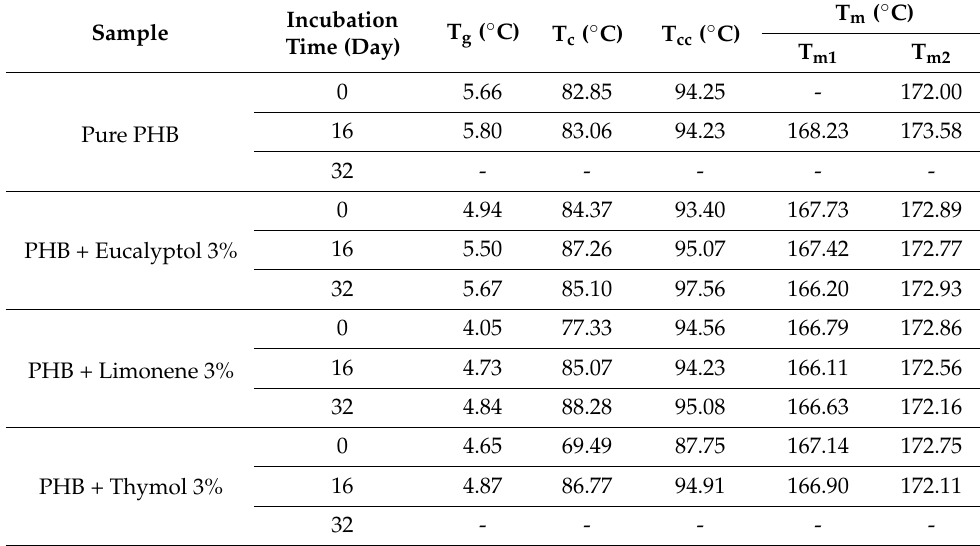
Table 3. DSC results of PHB/terpenoid blends (second